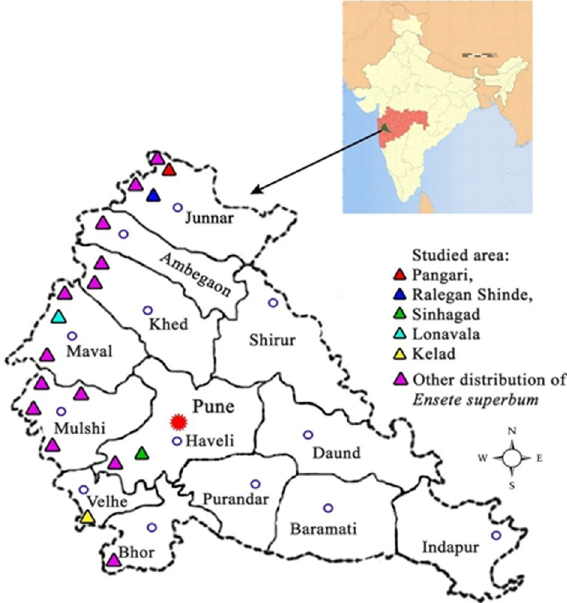
Figure 1. Location map of Pune District and the localities under present